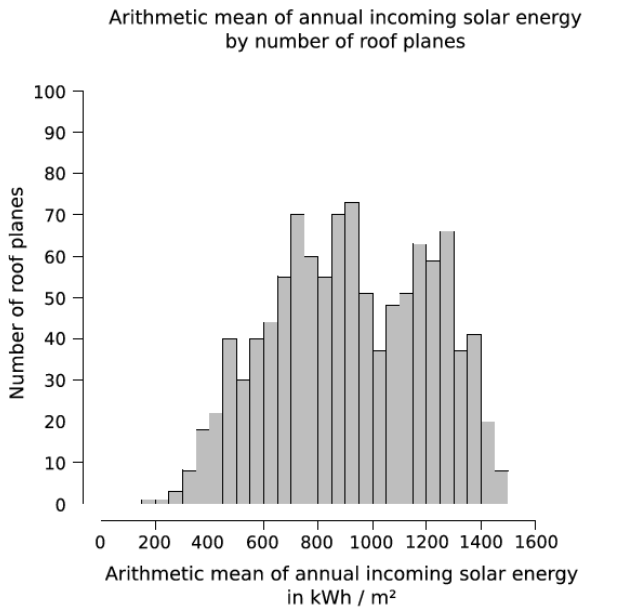
Figure 11. Arithmetic mean of annual incoming solar energy by number of roof planes. 75.5% of detected roof planes receive more than 700 kWh/m 2 of solar